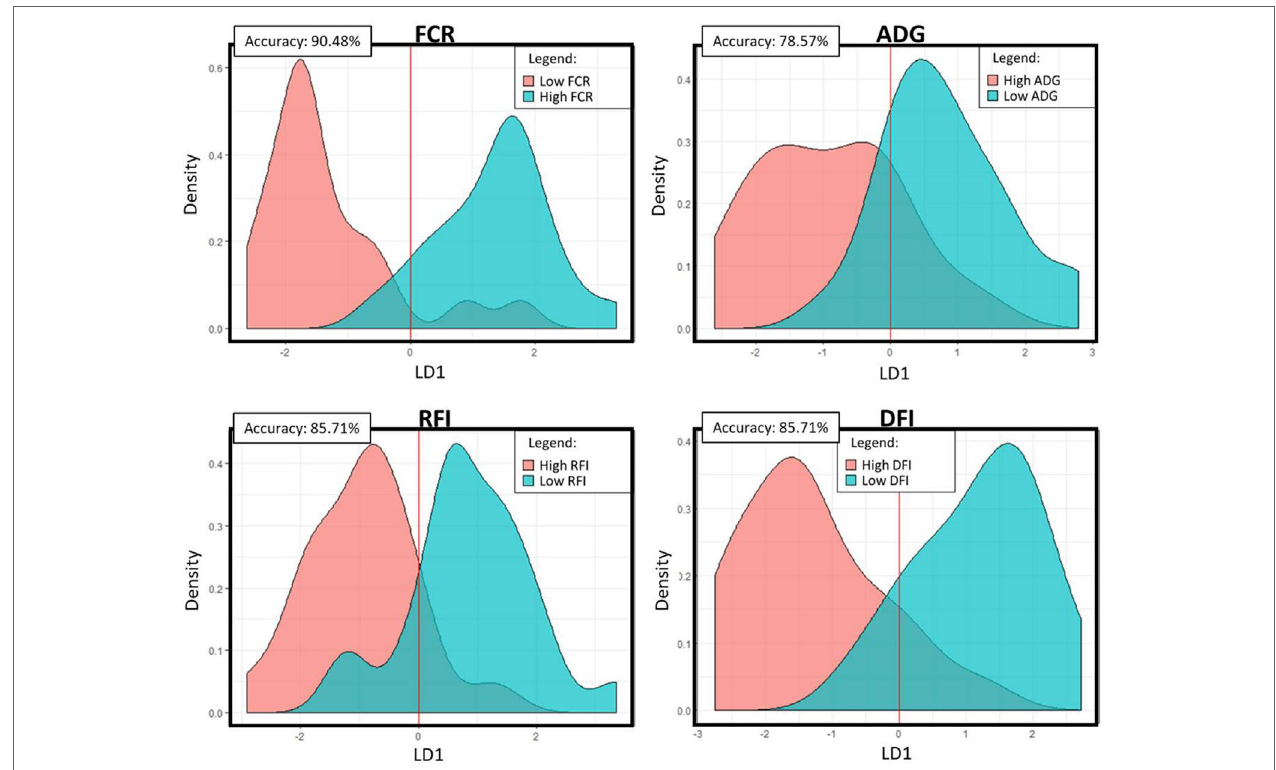
FIGURE 3 | Linear discriminant analysis density plots: Microbial genes identified in the PLS analyses to be significantly associated with the trait were used in a linear discriminant analysis of high- and low-performing animals. The density plots represent the predicted categories for each trait. The accuracy value represents the percentage of animals that were correctly assigned to their category. FCR, feed conversion ratio; ADG, average daily gain; RFI, residual feed intake; DFI, daily feed intake; LD1, linear discriminant